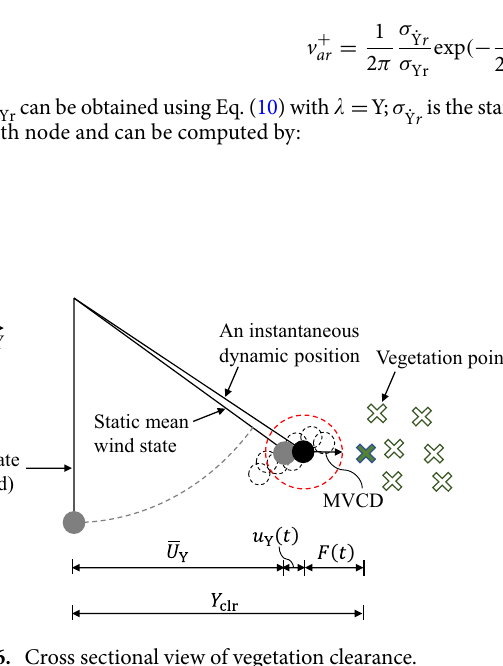
Figure 6. Cross sectional view of vegetation